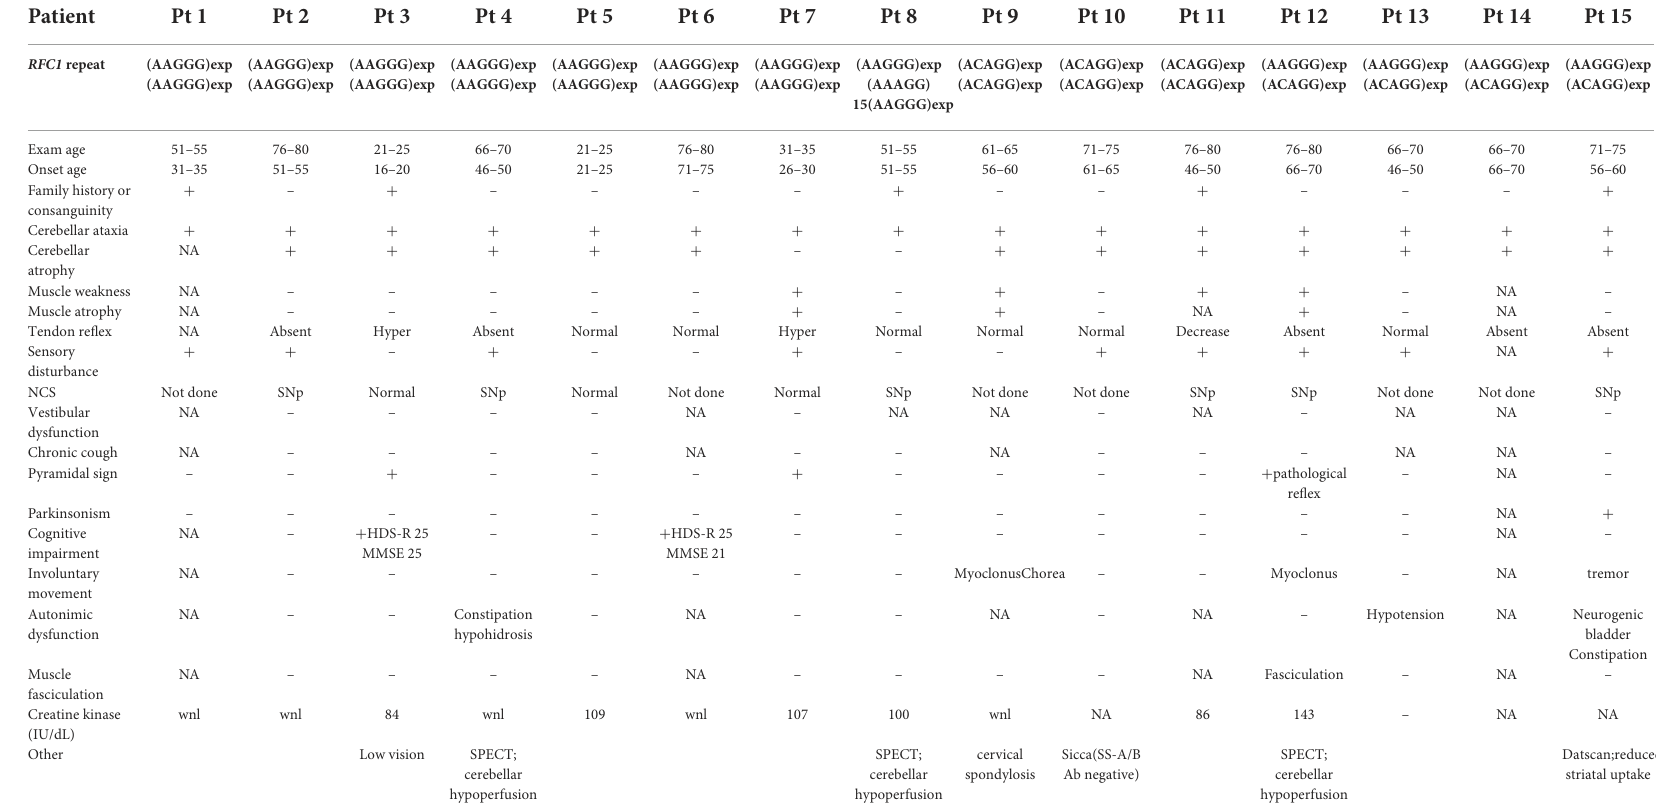
TABLE 1 Clinical features of patients with RFC1 repeat